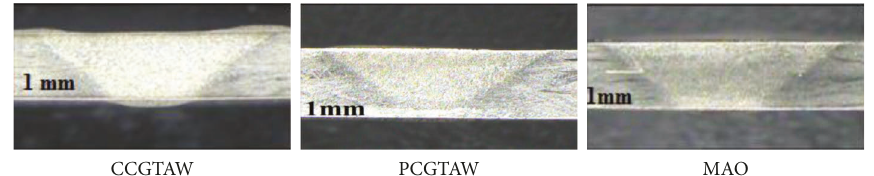
Figure 5: effect of CCGTAW, PCGTAW, and MAO on the fusion zone macrostructure.